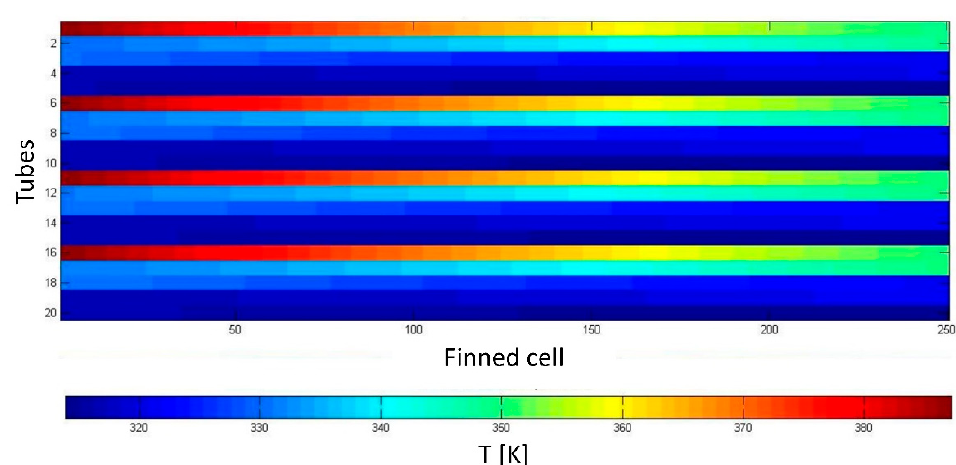
Figure 9. Temperature evolution of the refrigerant along the tubes of the first row of the gas cooler. The x -axis represents the number of finned cells for each tube (shown on the y -axis). The figure lies on the x–z geometrical plane. The experimental distribution of the airflow was considered for the simulations.